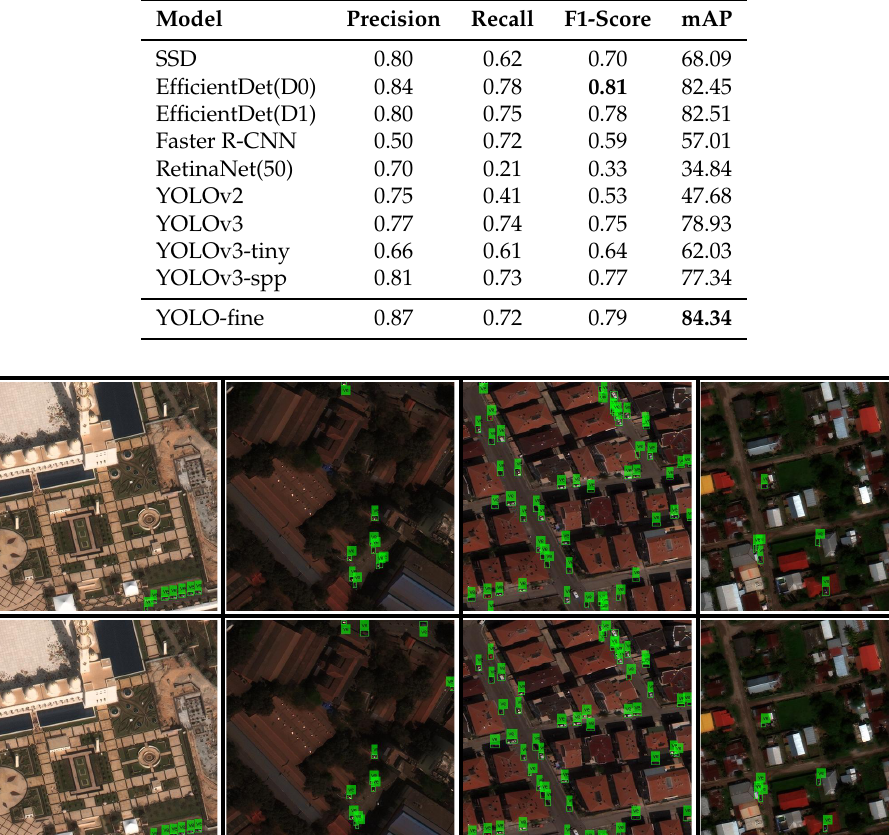
Table 7. Detection results on XVIEW. Best results of F1-score and mAP in bold.